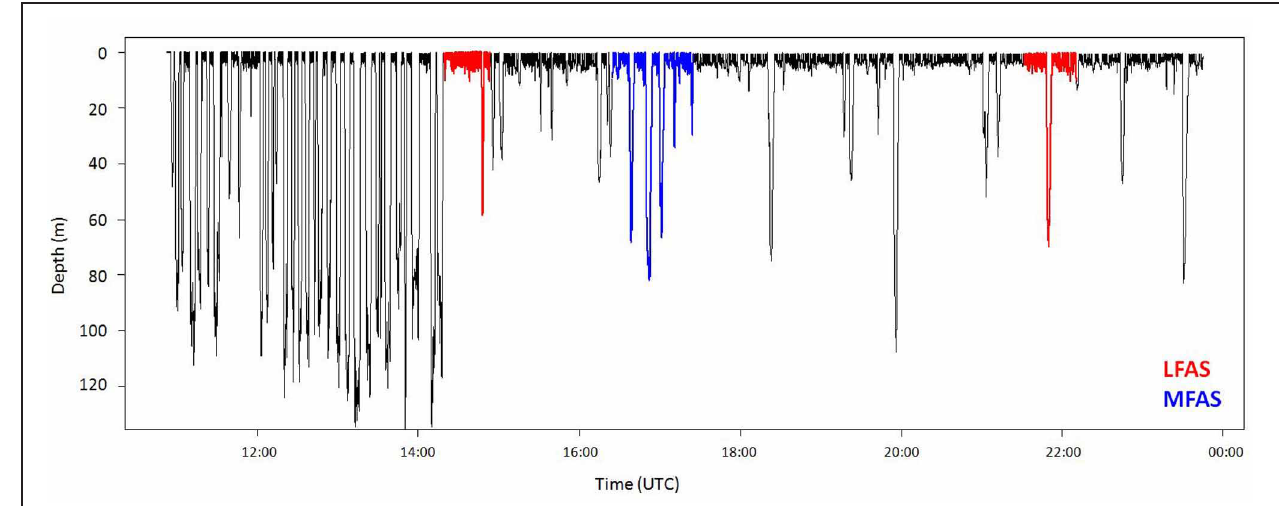
FIGURE 2 | Full dive record of killer whale oo09_144b. The whale made deep dives prior to the first LFAS exposure, and stopped deep diving at onset (red). Both prior to and during MFAS exposure (blue), the killer whale